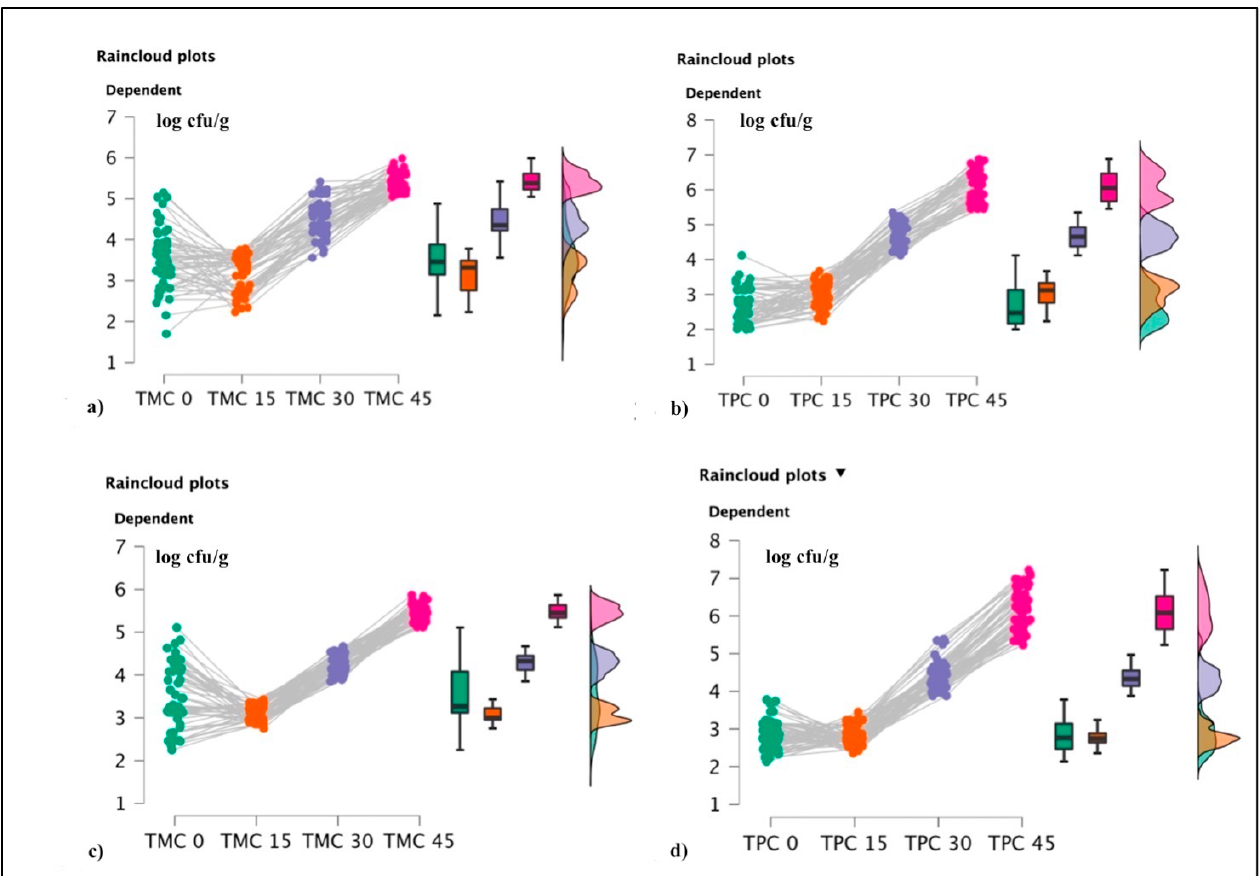
Figure 5. Raincloud plots representing. For each graphic, the vertical axis reports the calculated bacterial loads, and the horizontal axis indicates TMC and TPC values during the shelf life evaluations. More in detail, ( a ) TMC values for OTR1; ( b ) TPC for OTR1; ( c ) TMC for OTR2; and ( d ) TPC for OTR2.